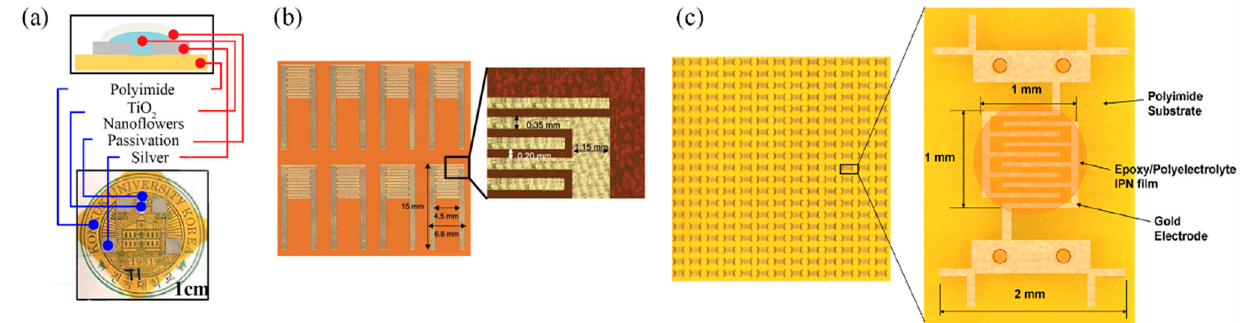
Figure 6. ( a ) A gravure-printed set of Ag electrodes with a drop-cased TiO 2 nanoflower sensing film (reproduced with permission from [14] copyright 2019, Elsevier); ( b ) screen printing and electroless plating of electrodes on Kapton (reproduced with permission from [15] copyright 2012, The Royal Society of Chemistry); ( c ) screen-printable active film deposition of Au electrodes, on Kapton substrate (reproduced with permission from [18] copyright 2013, Elsevier).